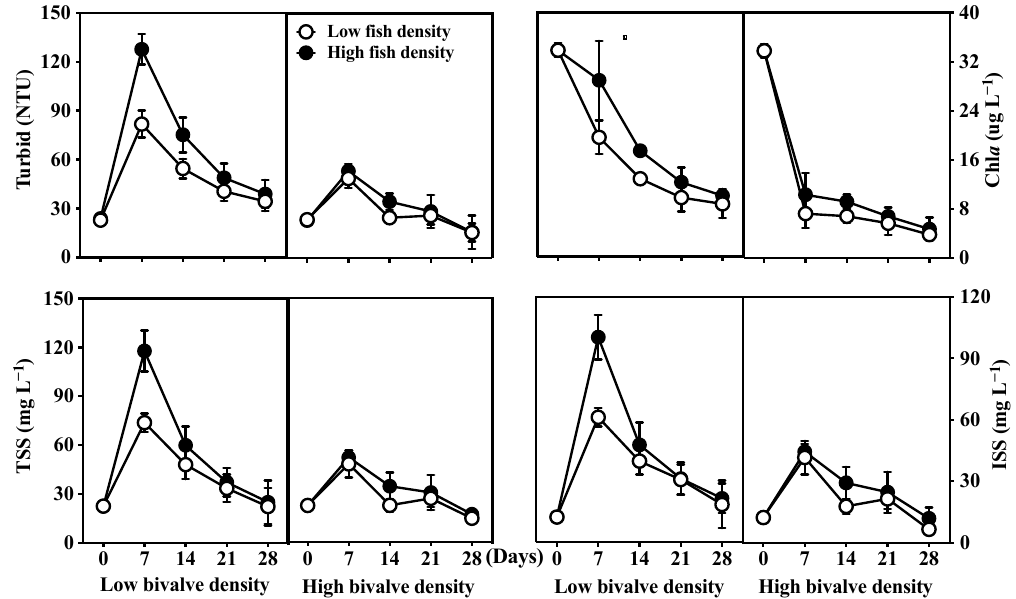
Figure 4. Time series of turbidity, Chl a, TSS and ISS in the different treatments during the experiment (means ± SD).